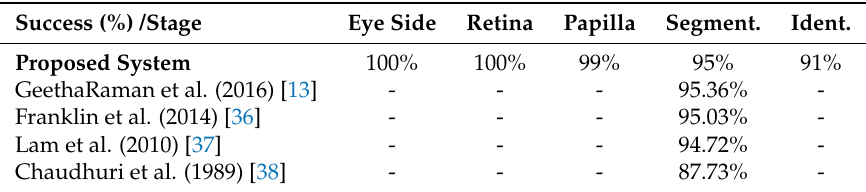
Table 1. Success rate for every step and comparative in blood vessel segmentation stage.